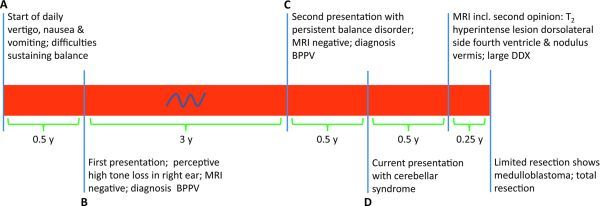
Timeline of clinical symptoms from first onset (left) until total resection of the tumour (right). Specifics for time points A–D can be found in the text. y, years; MRI, magnetic resonance imaging; BPPV, benign paroxysmal positional vertigo; DDX, differential diagnosis.